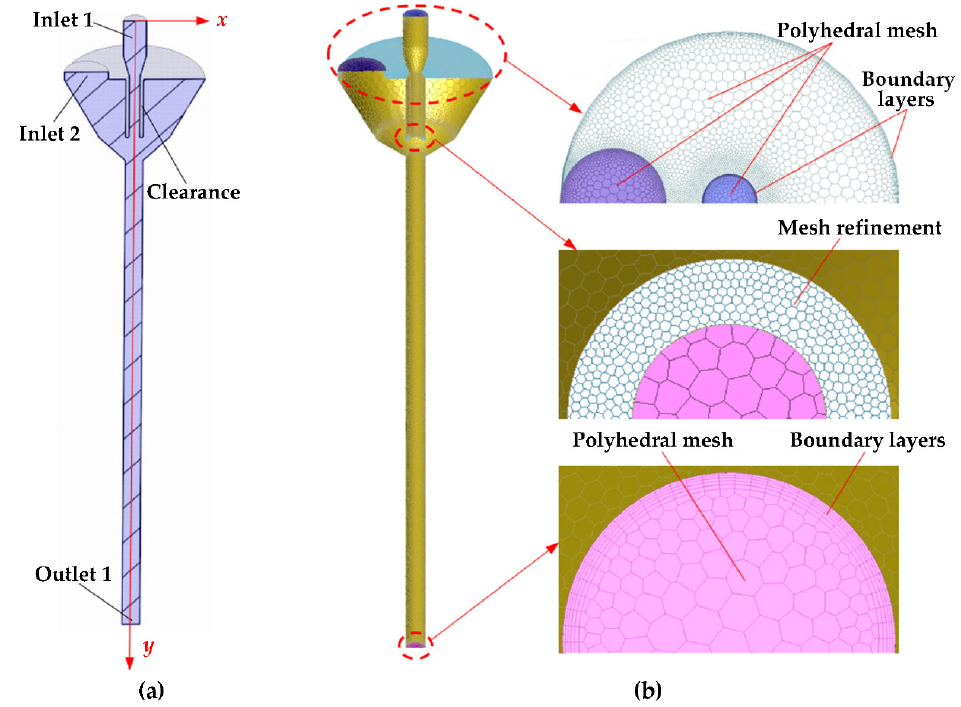
Figure 2. ( a ) Computational region of the PWSD. ( b ) Grids of the computational region.